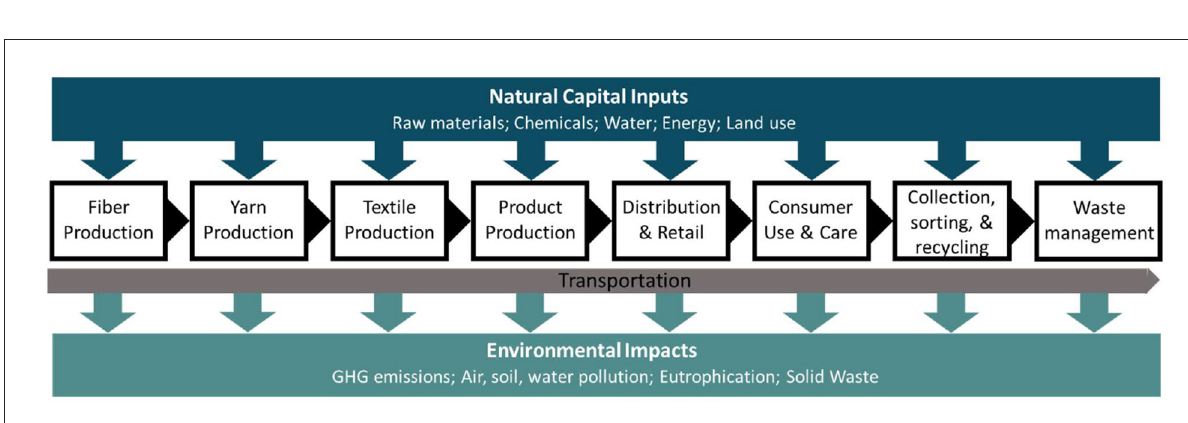
as manufacturing, distribution logistics, and retail (Niinimäki et al.,